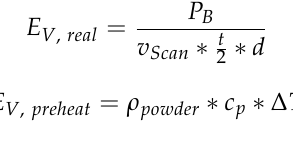
Table 3. Nomenclature and parameters used in calculating volume energy